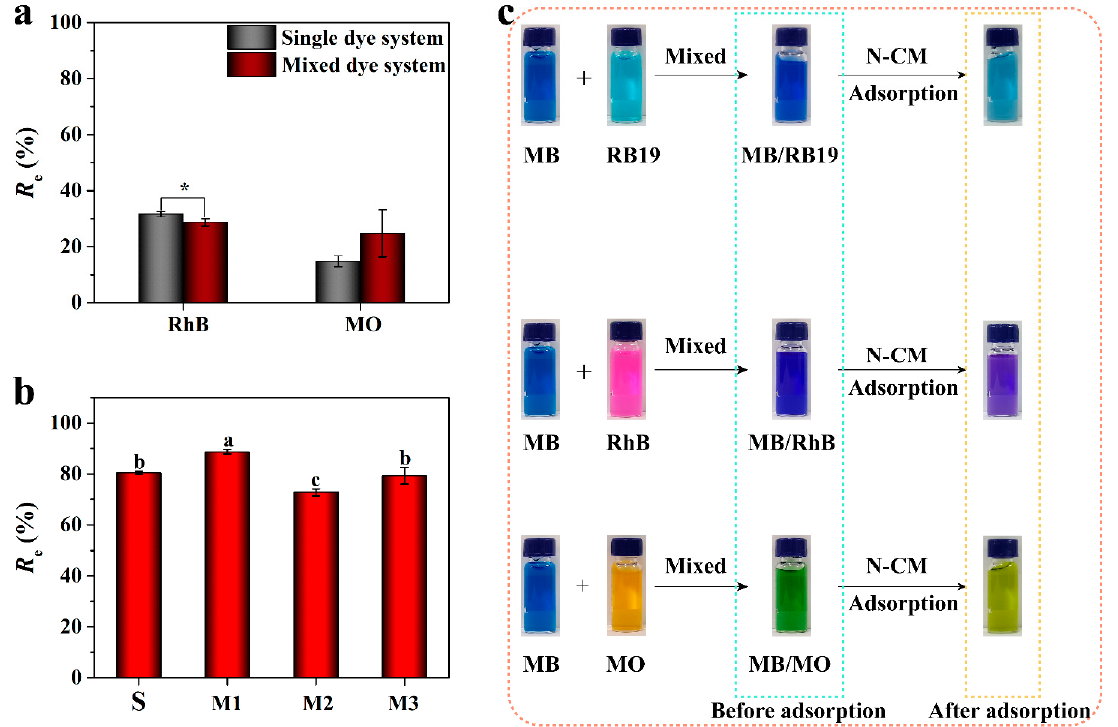
Figure 7. The selective adsorption of N-CM toward MB from various mixed dye systems: ( a ) The removal efficiencies of RhB (rhodamine B) and MO (methyl orange) from single and mixed dye system (one-way ANOVA with LSD test, * p < 0.05), vertical bars illustrate the mean ± SD ( n = 3). ( b ) The removal efficiencies of MB from single and mixed dye system, different letters indicate the statistically significant differences (one-way ANOVA, SNK test, p < 0.05). S indicates the single MB dye system; M1, M2 and M3 indicate the MB/RB19, MB/RhB, and MB/MO mixed dye systems, respectively. ( c ) Photographs of the selective adsorption of MB from MB/RB19, MB/RhB, and MB/MO dye systems. (in natural pH aqueous solution at 25 ◦ C for 72